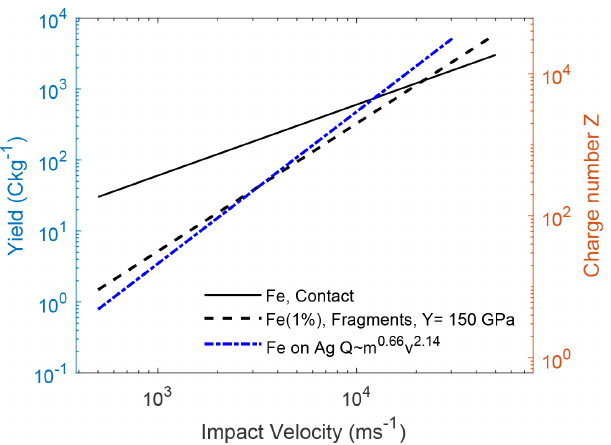
Figure 5. Simulation of contact charging of iron projectiles on a sil- ver target. This simulation was a “best-fit” run, in which the fraction of charged fragments, yield pressure, and fragment size span was allowed to change. This shows the case for χ = 0 . 01, cf. Eq. (5), Y = 150GPa, and fragment size span [0.7, 3]nm.